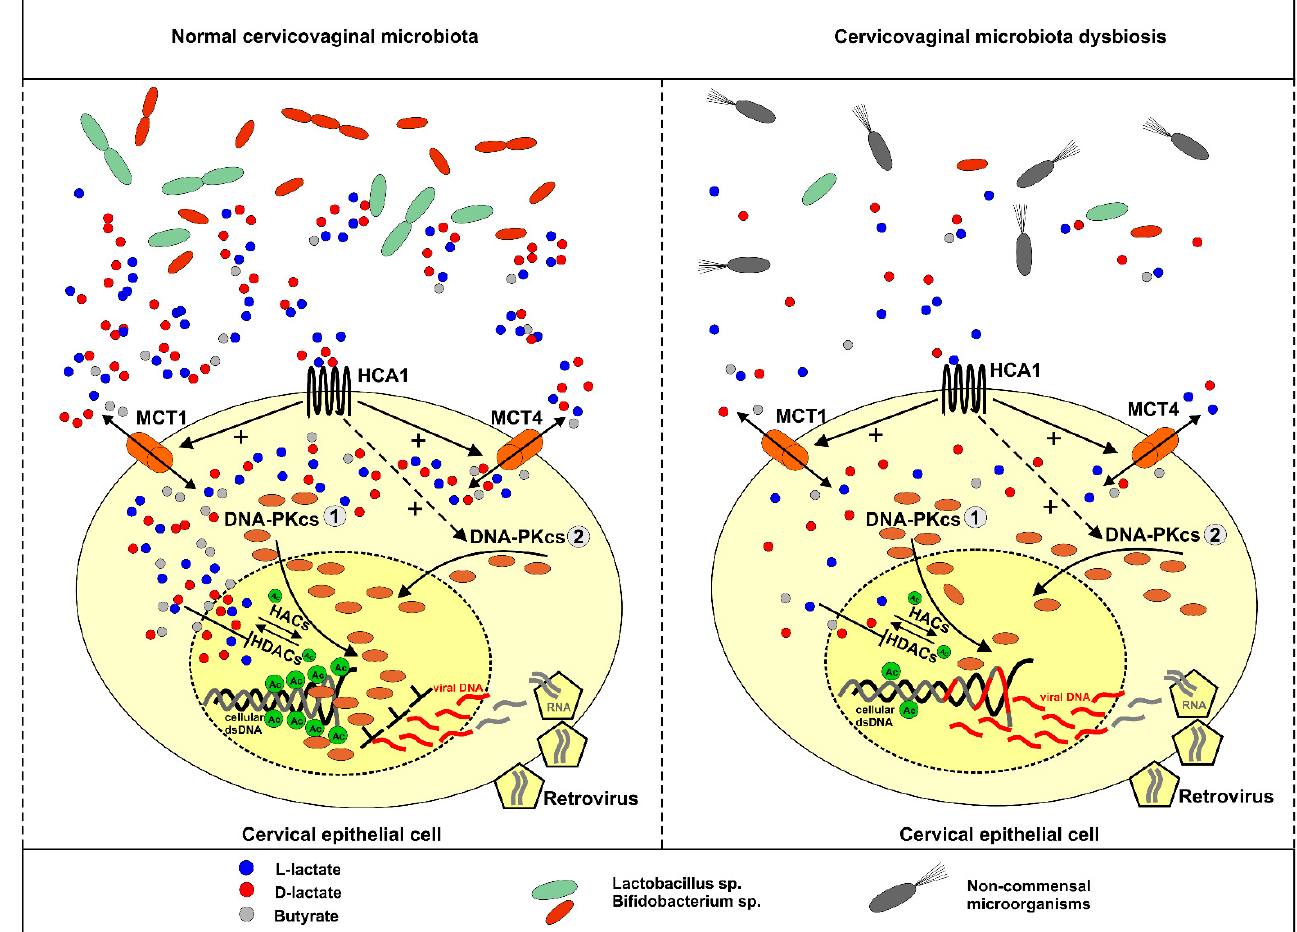
Figure 7. Illustration of hypothetic role of lactate in anti-lentiviral protection of female genital tract. Under normal conditions symbiotic microbiota produce L-/D-lactate and butyrate which can be imported by cervical epithelial cells through MCT1-4 transporters. In the nuclear compartment, lactate and butyrate inhibit histone deacetylases (HDACs), thus, promotes histones acetylation by histone acetylases (HACs). Acetylated histones induce chromatin relaxation and recruitment of DNA-PKcs to nucleus (1 pathway). Cervical epithelial cells bear HCA1, a specific receptor for lactate. Lactobacilli sp. derived lactate stimulates surface HCA1, induce cAMP signaling and cAMP/EPAC/PKA-dependent shuttling of DNA-PKcs to nuclear compartment (2 pathway). Excessive nuclear localization of DNA-PKcs protects cells from lentiviral (e.g., HIV-1) transduction. Cervicovaginal microbiota dysbiosis accounts for lactate shortage and insufficient anti-lentiviral protection of first-line defense epithelial cells.